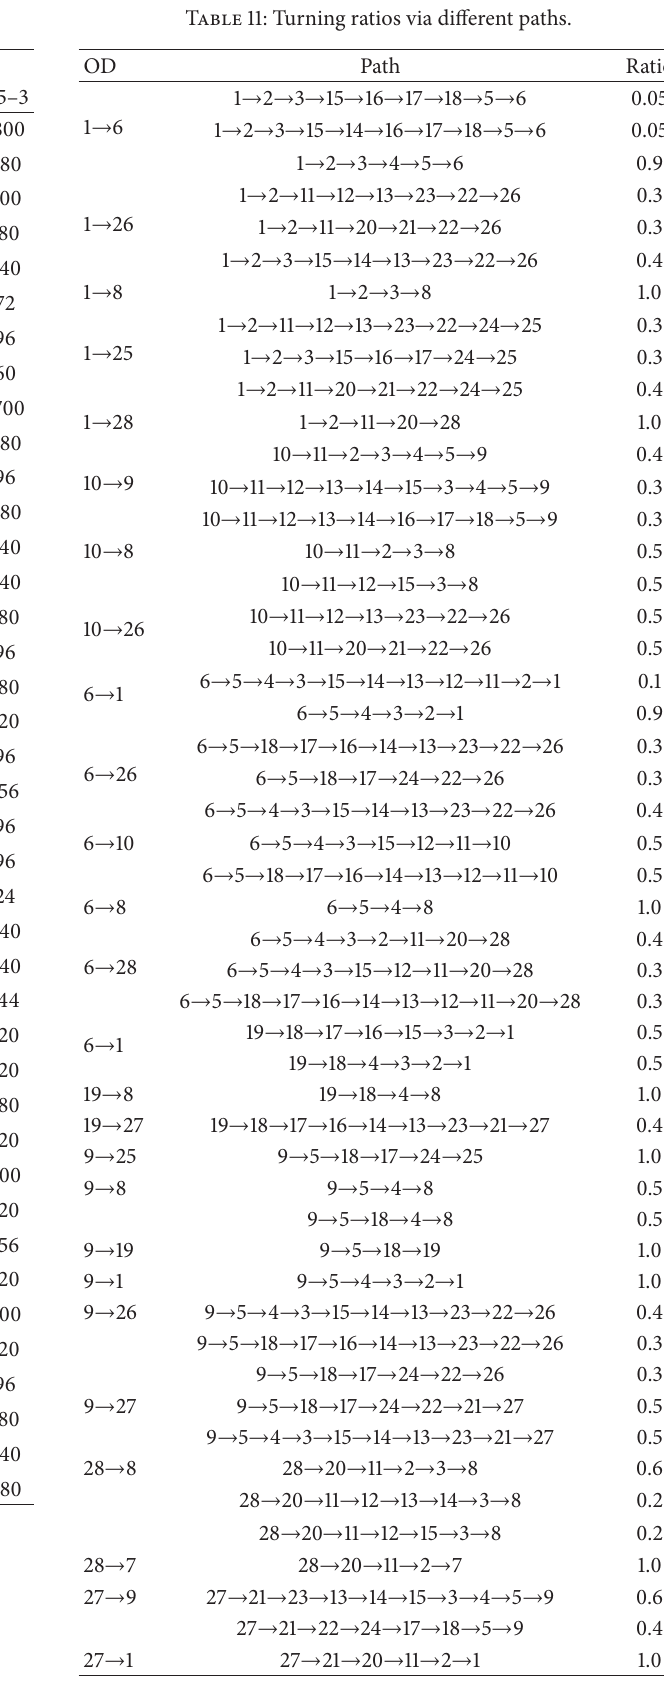
Table 11: Turning ratios via different